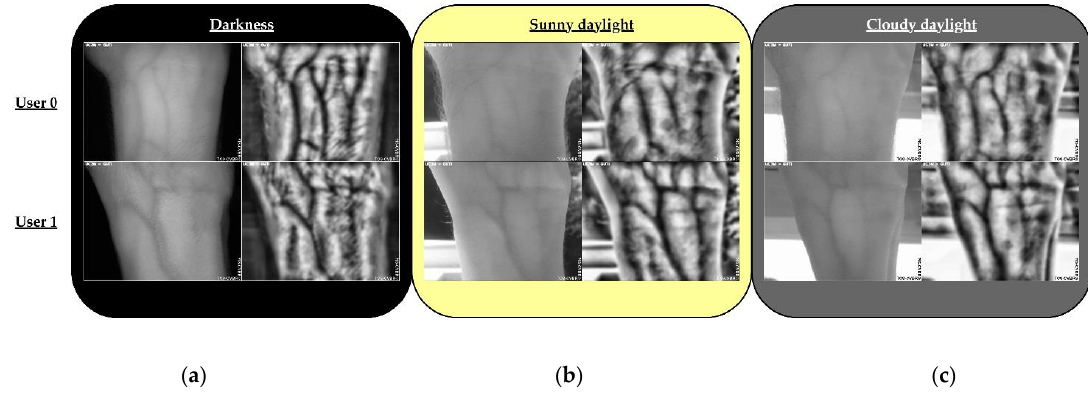
Figure 10. Results: outdoor external light conditions for User 0 (top row) and User 82 (bottom row). ( a ) Darkness. ( b ) Sunny daylight. ( c ) Cloudy daylight.